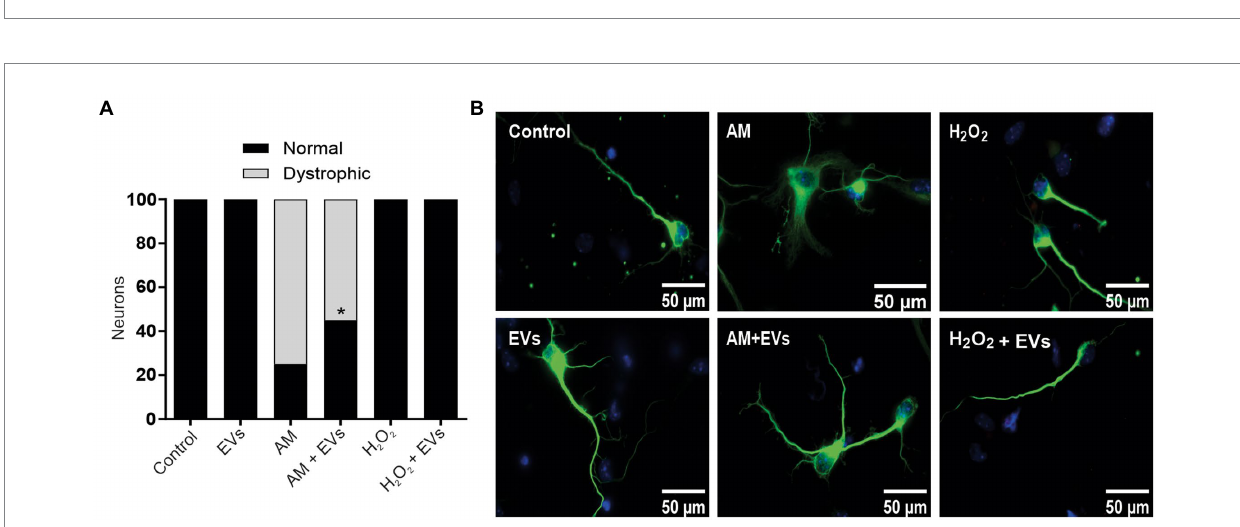
FIGURE 6 NSC-EVs restores morphology of dystrophic neurons. (A) Percentage of normal neurons (black bars) and dystrophic neurons (grey bars) after 3 days in culture medium under the indicated conditions. (Student’s T-test) * p < 0.05. (B) Representative images of neurons incubated under the indicated conditions (100X) Scale bars: 50 μ